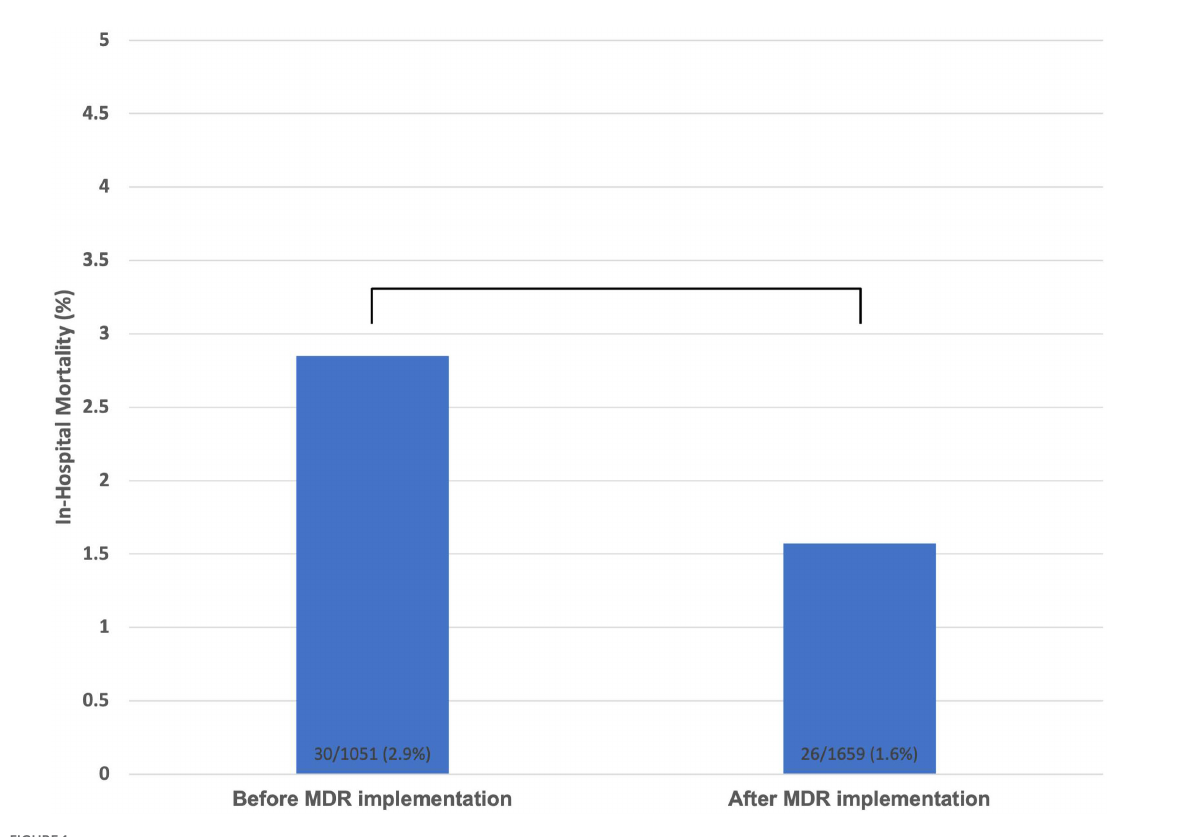
FIGURE1 All-cause in-hospital mortality prior to and after multidisciplinary rounds